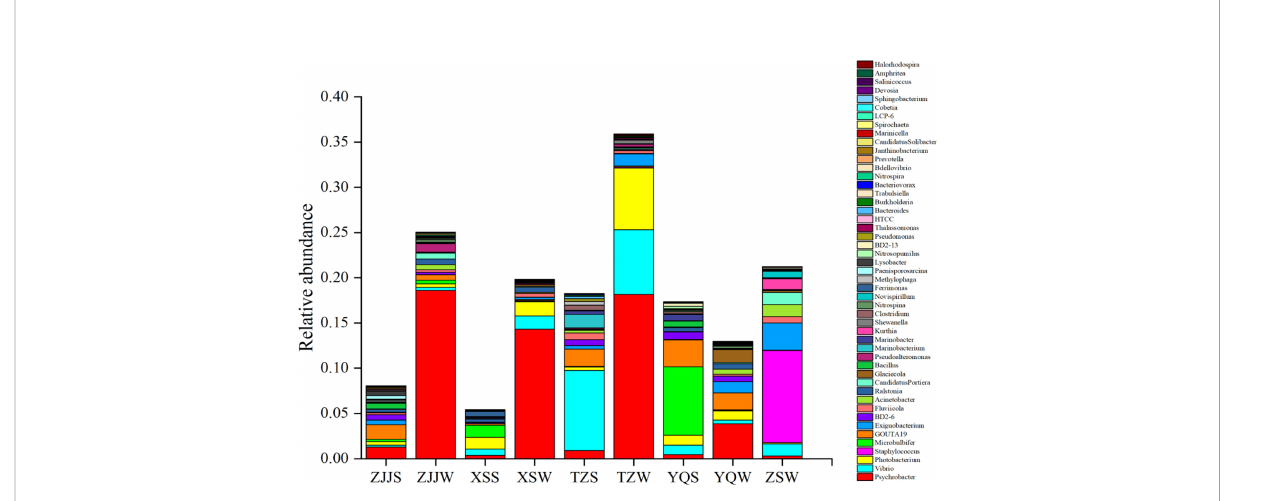
FIGURE 7 The species and relative abundance of potential pathogenic bacteria in the top 50 genera using the BugBase